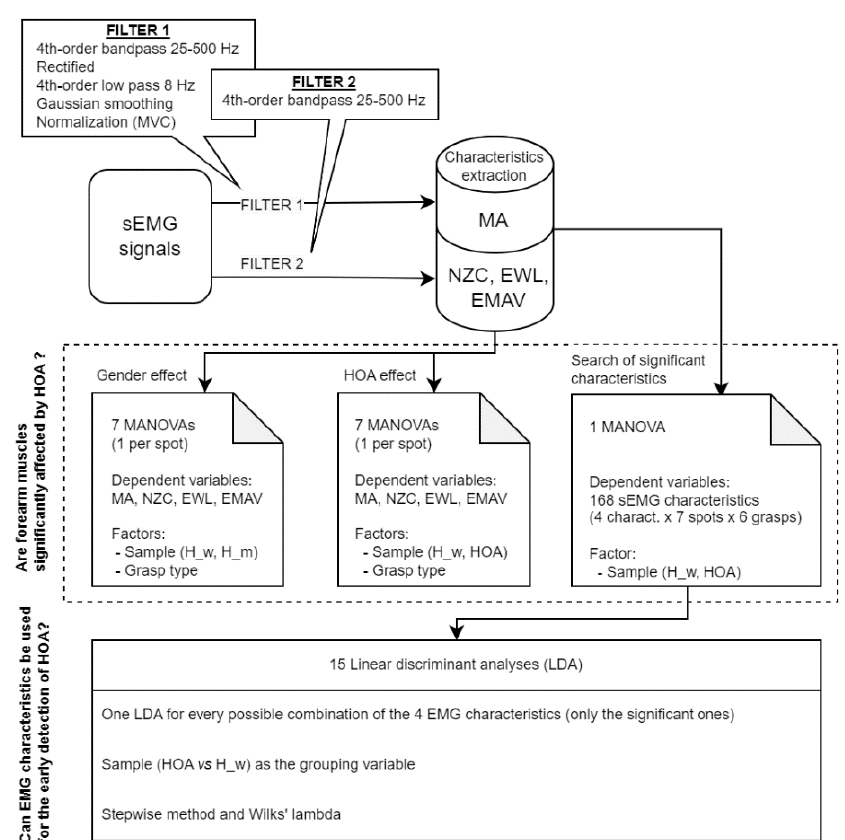
Figure 4. Flowchart of the methodology followed in this paper.